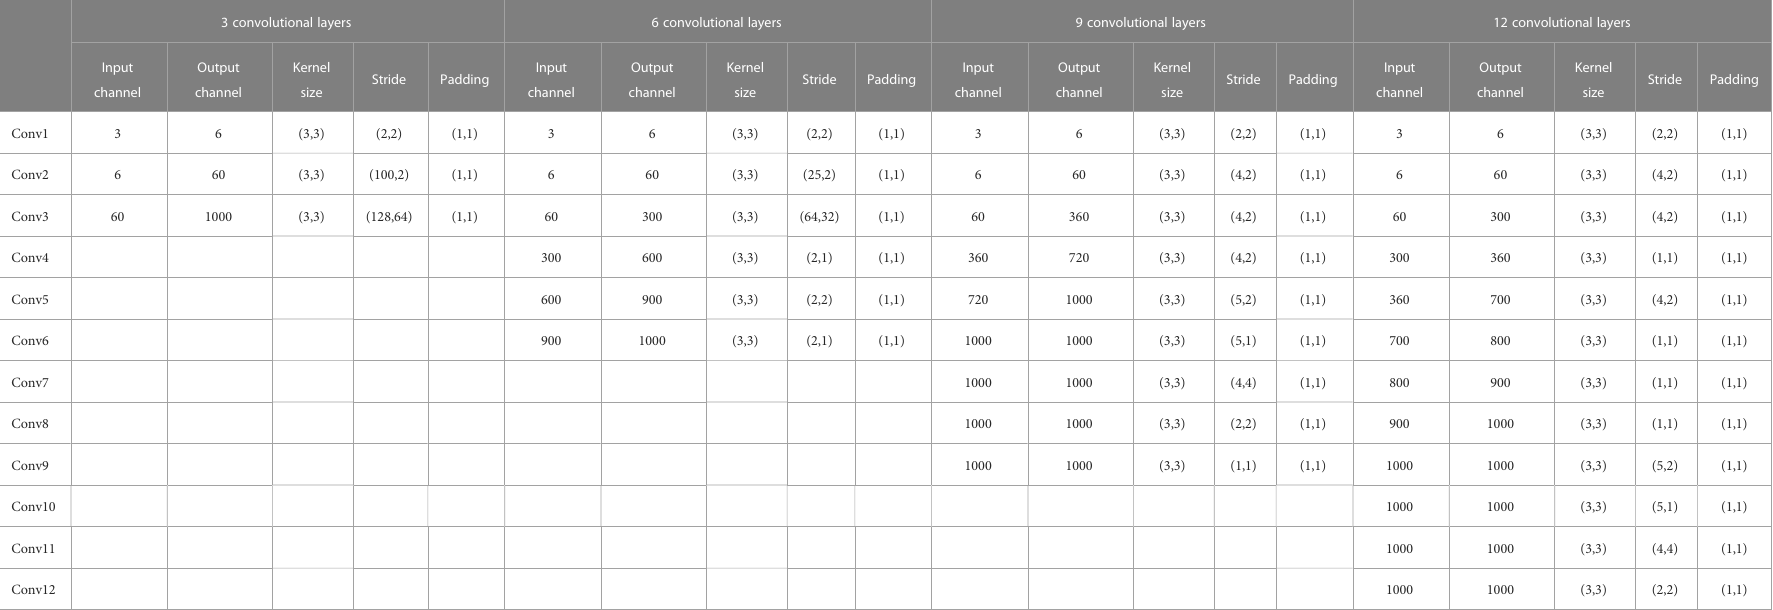
TABLE 1 Parameters of each group of the comparison